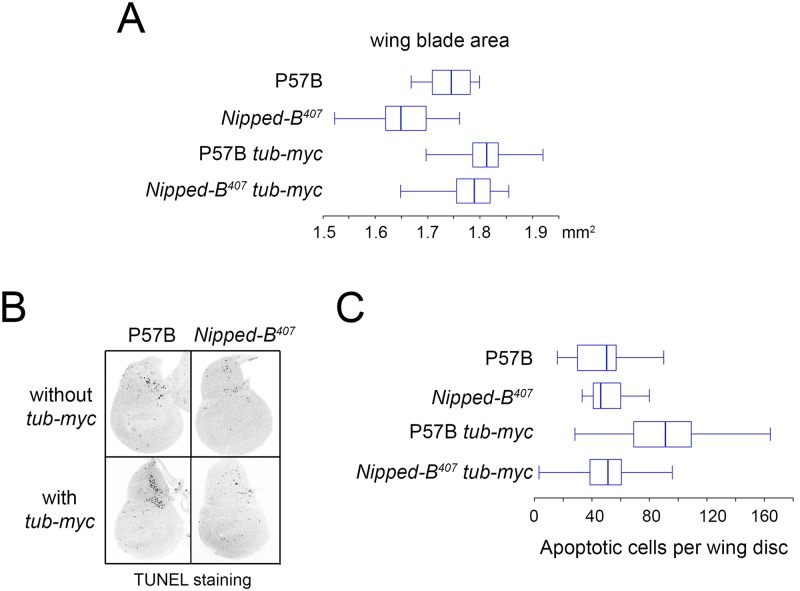
Additional myc (dm) expression rescues adult wing size of Nipped-B
407 heterozygous mutants and increases apoptosis in wild-type 3rd instar wing imaginal discs.(A) The box plots indicate the distribution of the wing blade areas of the indicated genotypes, where tub-myc indicates a single copy of the tub-myc transgene that expresses Drosophila dm from a minimal tubulin gene promoter. The increases in wing area induced by tub-myc are significant for both the P57B / + and Nipped-B
407 / + genotypes (p<0.0001, t test). Cell numbers and sizes were also determined for each genotype and are given in Table 3. (B) Examples of TUNEL staining of late 3rd instar wing imaginal discs of the indicated genotypes to visualize apoptotic cells. (C) Boxplot distributions of the number of apoptotic cells in 3rd instar wing discs. The number of apoptotic cells in P57B / + discs with the tub-myc transgene is significantly higher than the other genotypes (p<0.0001, student t test).